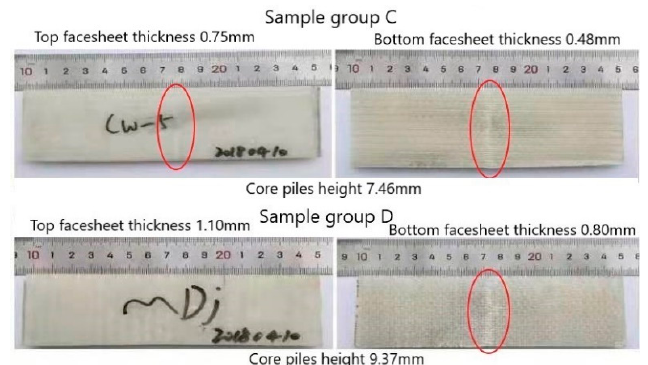
Figure 13. Reverse view of the damaged samples.